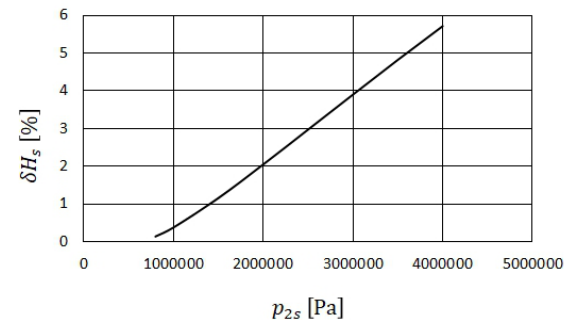
Figure 6. Relative deviation of isentropic work cal- culated for real and ideal